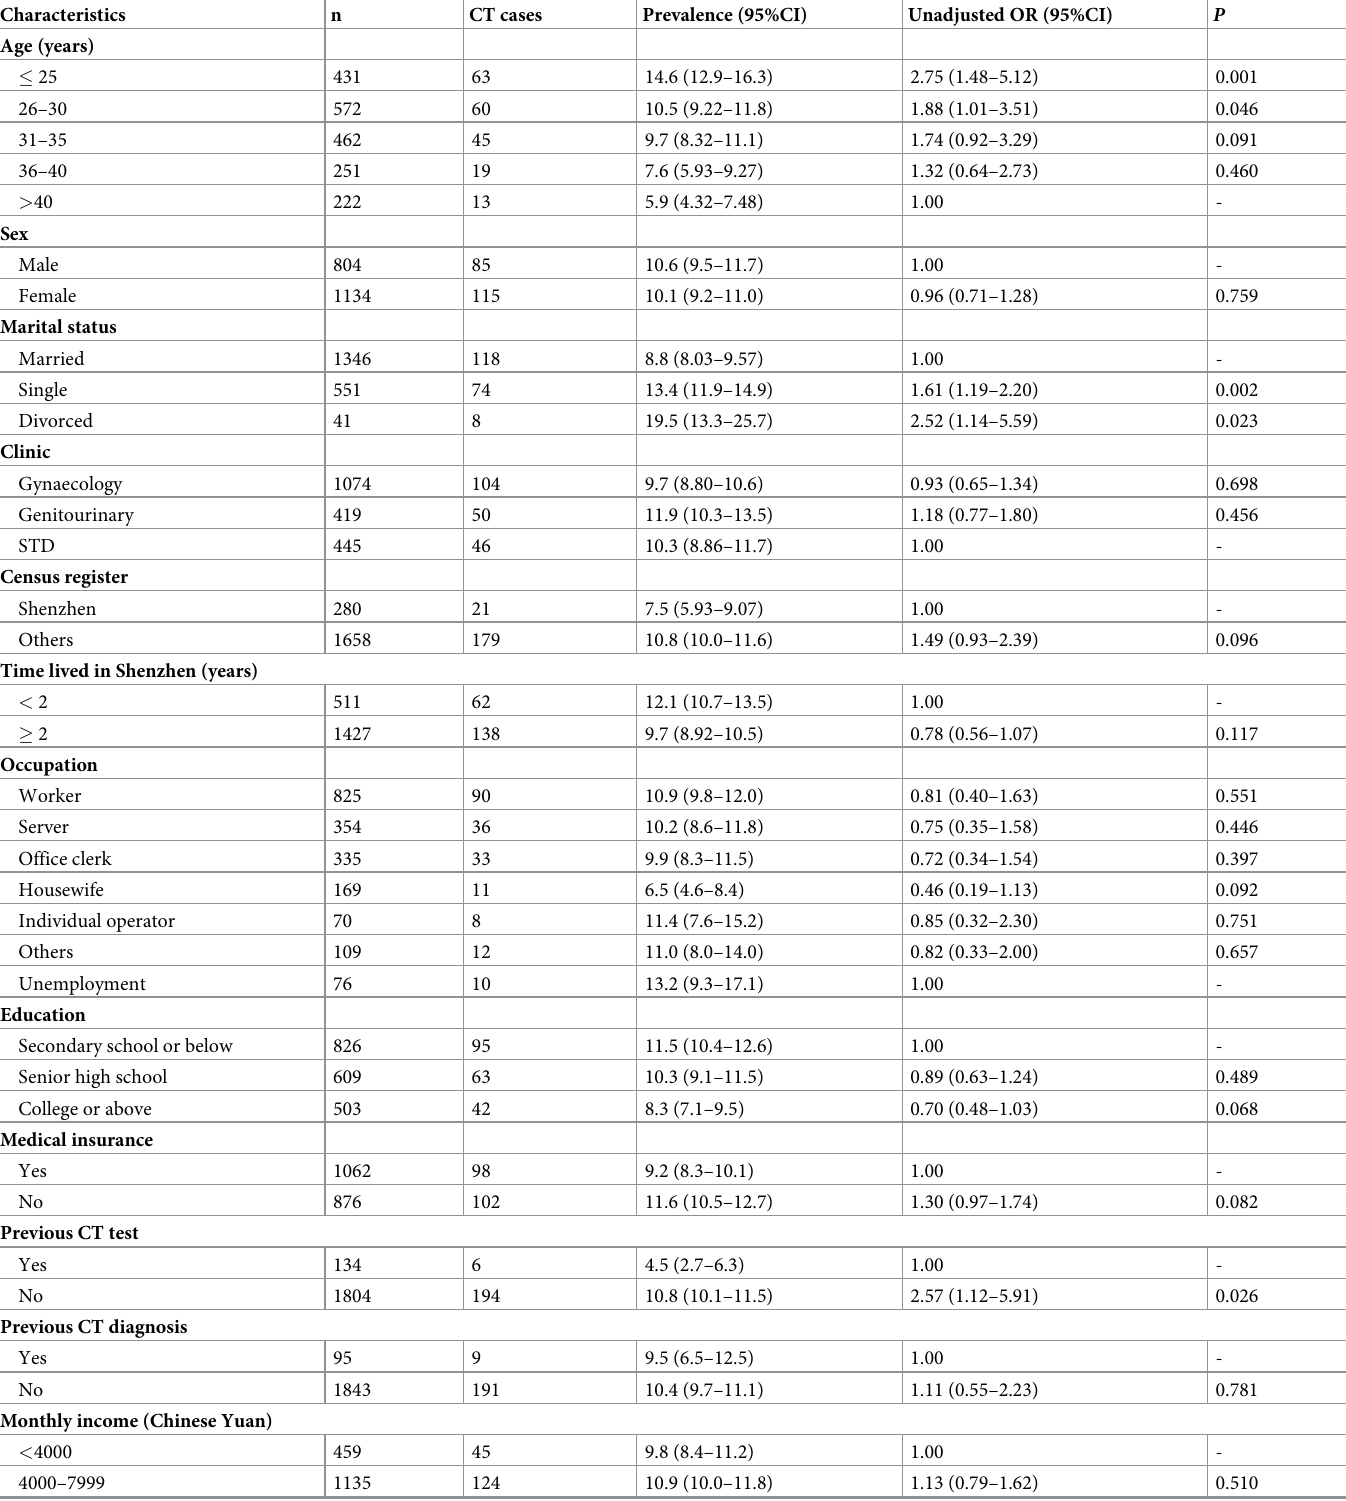
Table 2. Prevalence of CT and unadjusted OR by characteristics.